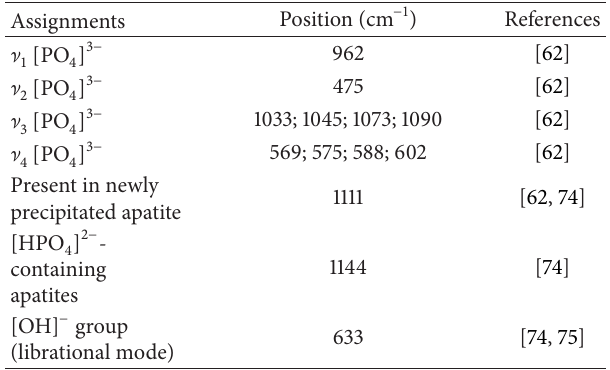
bands of Eu:HAp spectrum from second derivative.